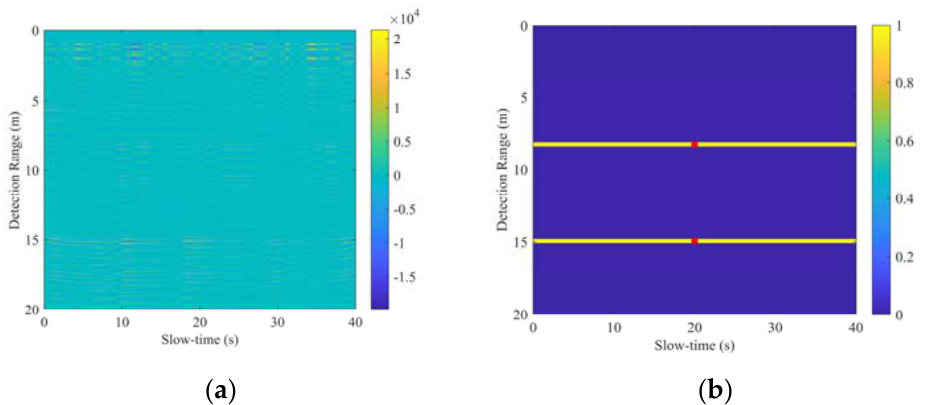
Figure 18. Results of Scenario 2: ( a ) range-slow-time matrix obtained after step A; ( b ) TPOIs extracted by CNN.